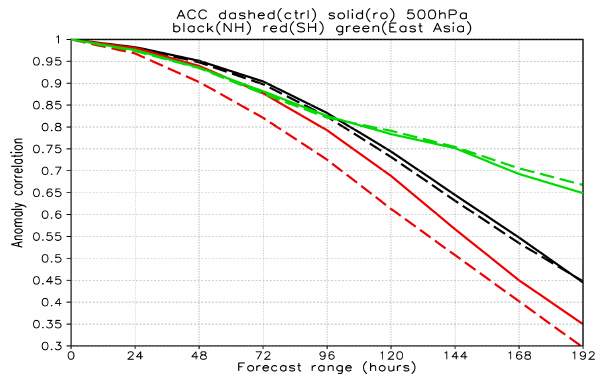
Figure 5. Anomaly correlation coefficient (ACC) for the 500mb height for the 8-day forecast. The dashed line denotes the con- trol experiment only assimilating conventional observation, and the solid line denotes the RO assimilation experiment. The black lines denote the Northern Hemisphere, the red lines denote the Southern Hemisphere, and the green lines denote the East Asia. Experiment period is from 12:00UTC on 1 July to 12:00UTC on 31 July 2011; it is from 31 samples (from Liu and Xue, 2014).